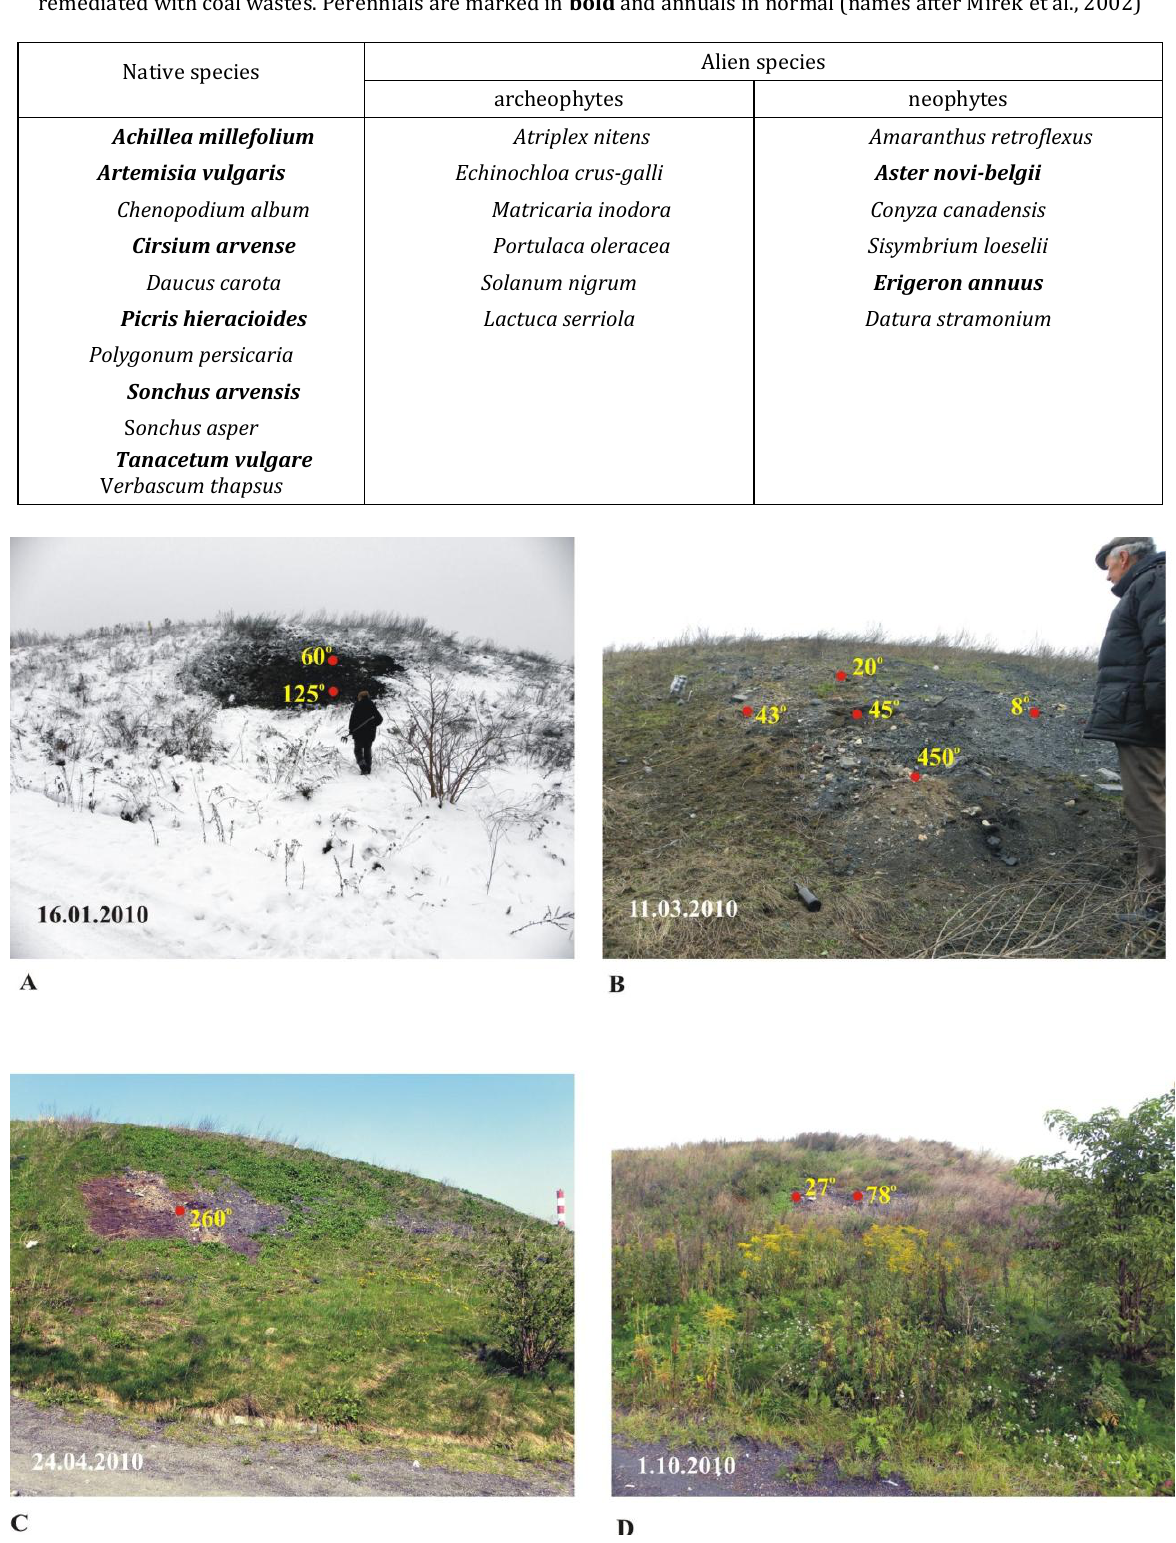
Table. 1. Main species of vascular flora encroaching on burned places on the Katowice-Wełnowiec municipal waste dump remediated with coal wastes. Perennials are marked in bold and annuals in normal (names after Mirek et al., 2002)